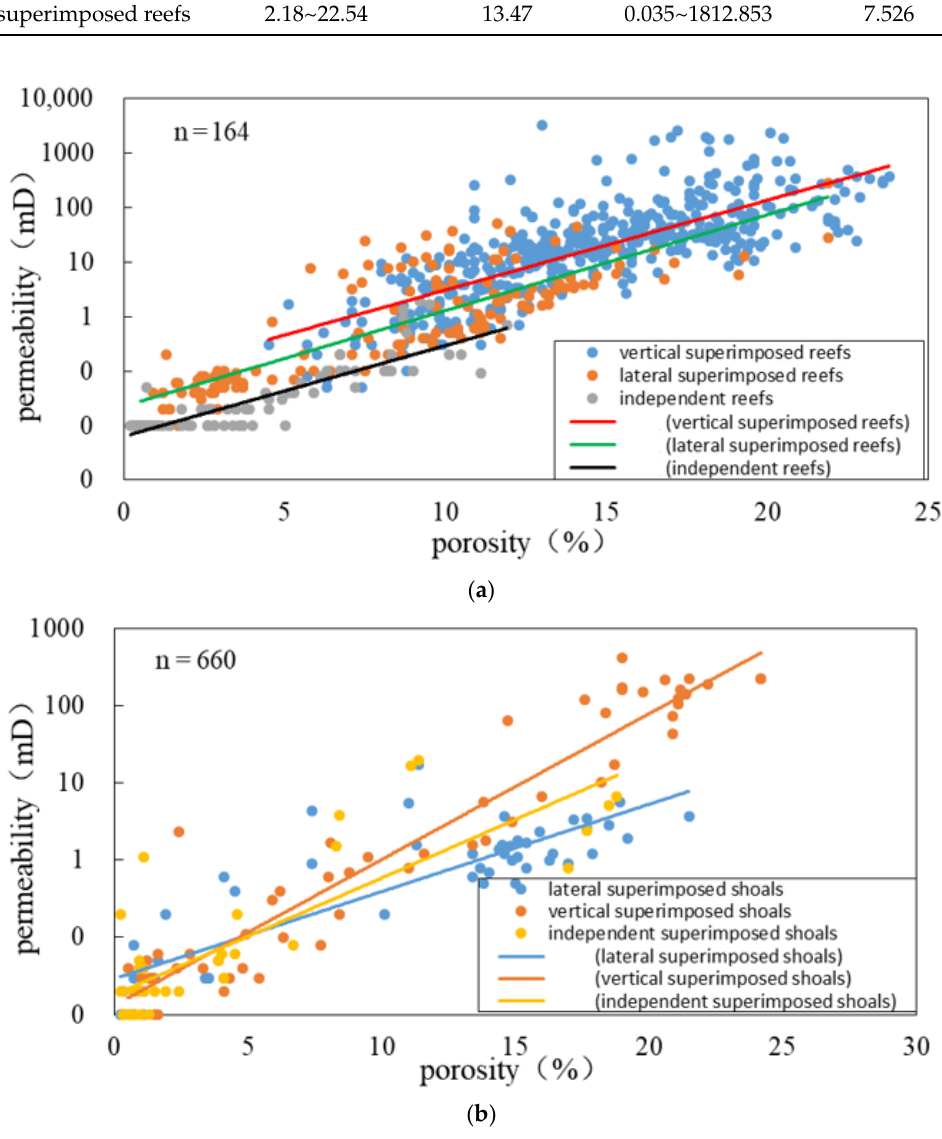
Figure 8. ( a ) Porosity and permeability scatter diagram of three types of reef architecture; ( b ) poros- ity and permeability scatter diagram of three types of shoal architecture. and permeability scatter diagram of three types of shoal